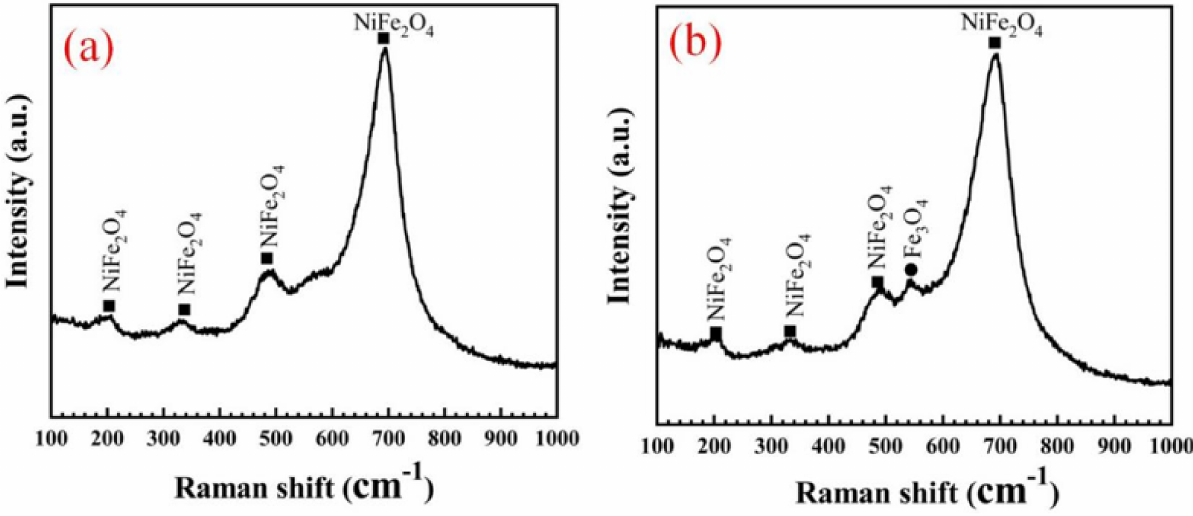
Figure 6. Raman spectrum of the fouling at different positions of the SG tube after 500 h of immersion at 290 ◦ C; ( a ) position 1, ( b ) position